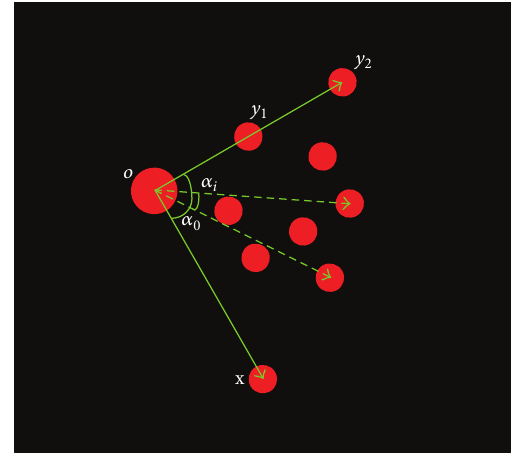
Figure 6: Recognition of reference